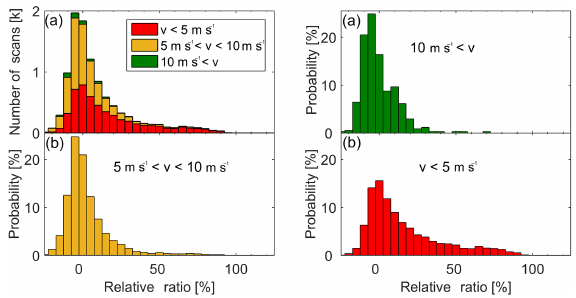
Figure 16. Histograms of the underestimation for different wind speeds at Tungurahua. The results show data from all three instru-